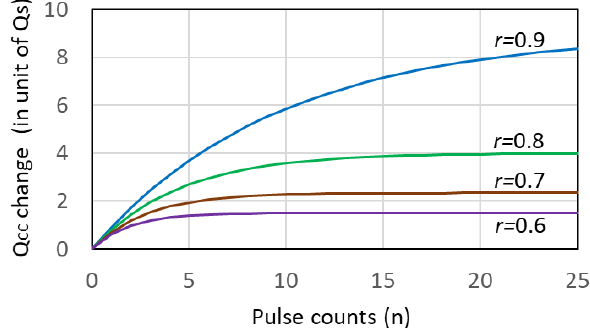
𝑛 Figure 16. The function 𝑟 ･ 1−𝑟 appeared as the coefficient of Q S in Equation (14) showing 1−𝑟 nonlinearity with respect to n . For n larger than 10, strong deviation from linearity is observed even for r =